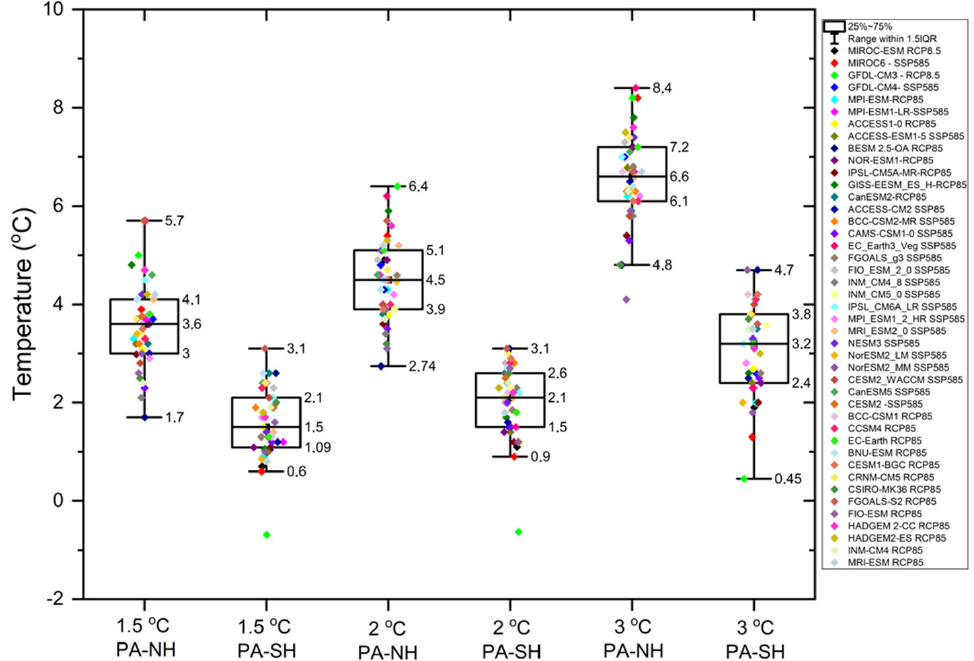
Figure 4. Polar Amplification simulated by CMIP5 and CMIP6 climate models for the temperature thresholds of +1.5 °C, 2.0 °C and 3.0 °C global mean warming under RCP8.5 and SSP585 scenarios of northern and southern hemispheres high latitudes. The boxplot was defined by using two lines at the 25th percentile and 75th percentile. The 25th percentile is the value at which 25% of the data values are below this value. Thus, the middle 50% of the data values fall between the 25th percentile and the 75th percentile. The distance between the upper (75th percentile) and lower (25th percentile) lines of the box is the inter-quartile range.